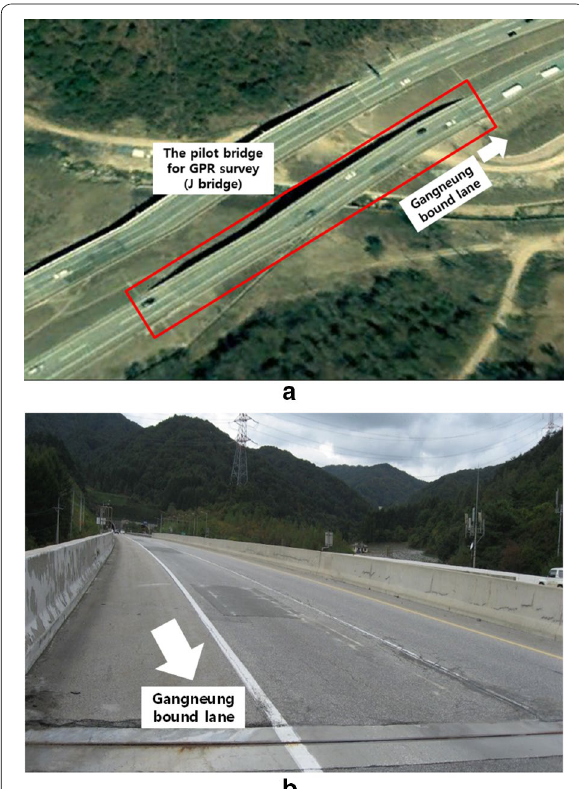
Fig. 2 Photos of the pilot bridge (‘J’ bridge); a aerial plan view of the pilot bridge obtained from Google maps (an image taken on April 23, 2005), b overall view showing the surface condition (patching, cracking, efflorescence, etc.) of the pilot bridge taken on the Gangneung bound lane (an image taken on the survey day).